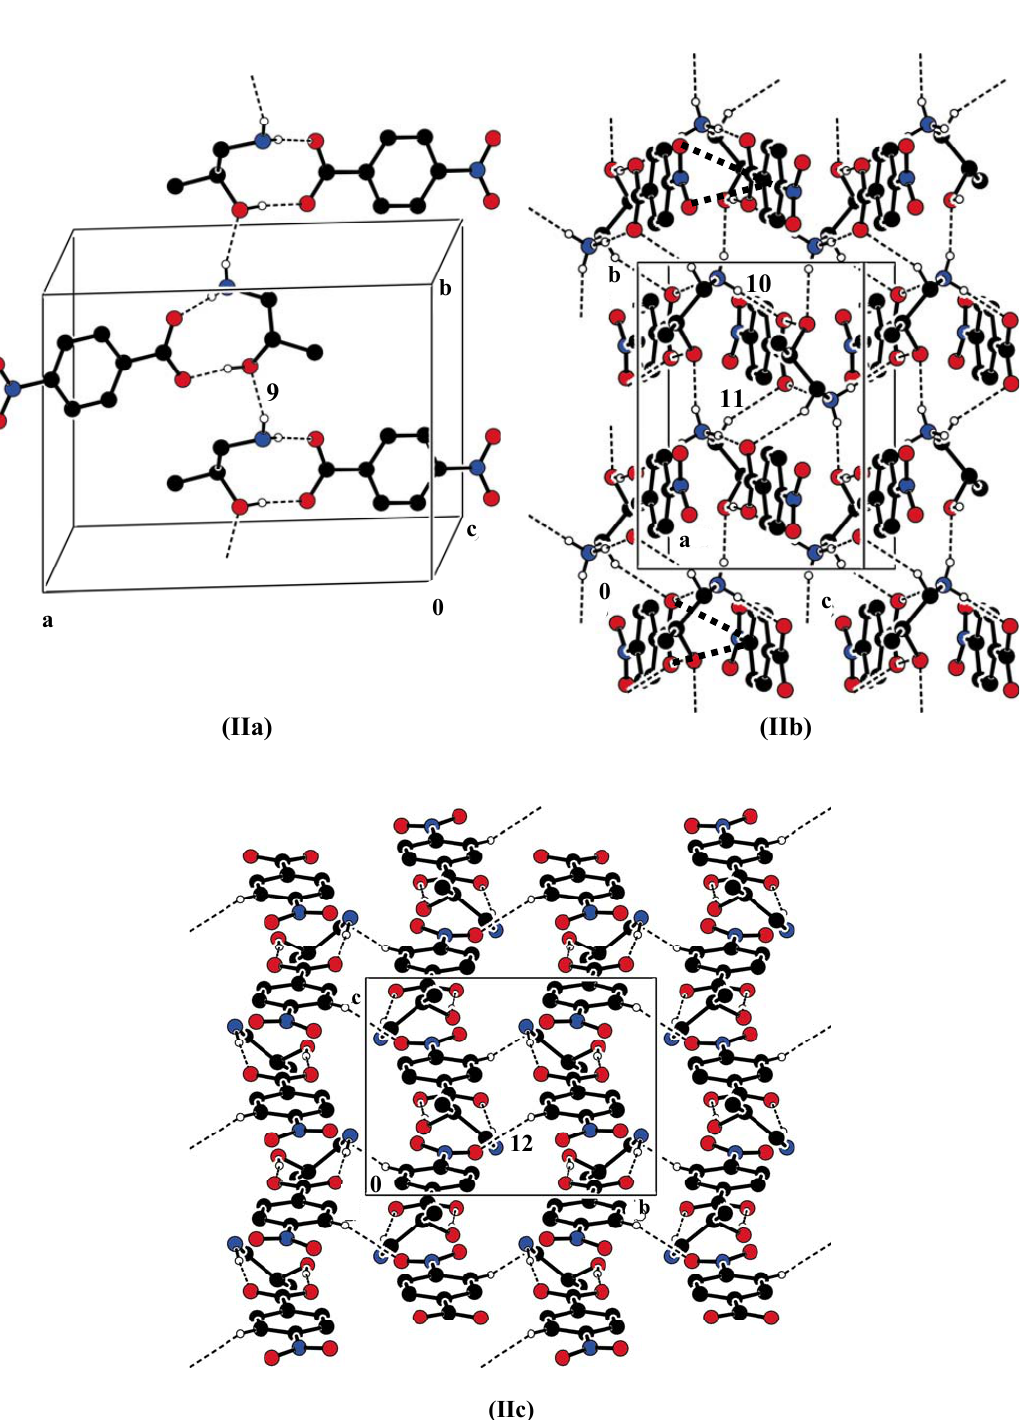
Fig. 3 ( IIa ) The helix-like chains along b direction in II formed by N2 ... O5 (9) hydrogen bonds (dashed